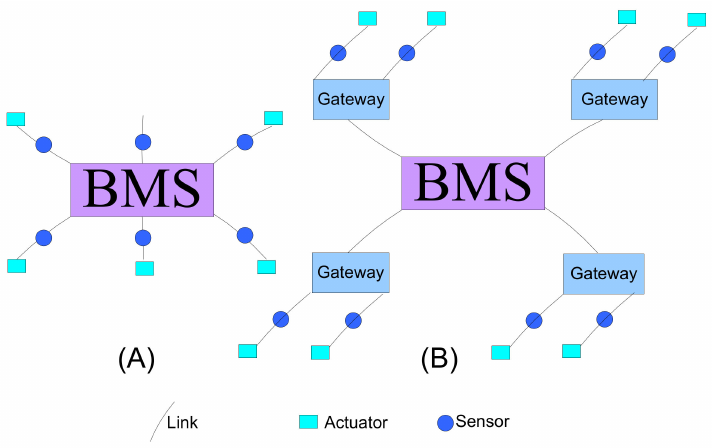
Figure 5. Implementation topology for a battery-management system. ( A ) Centralized ( B ) Distributed.